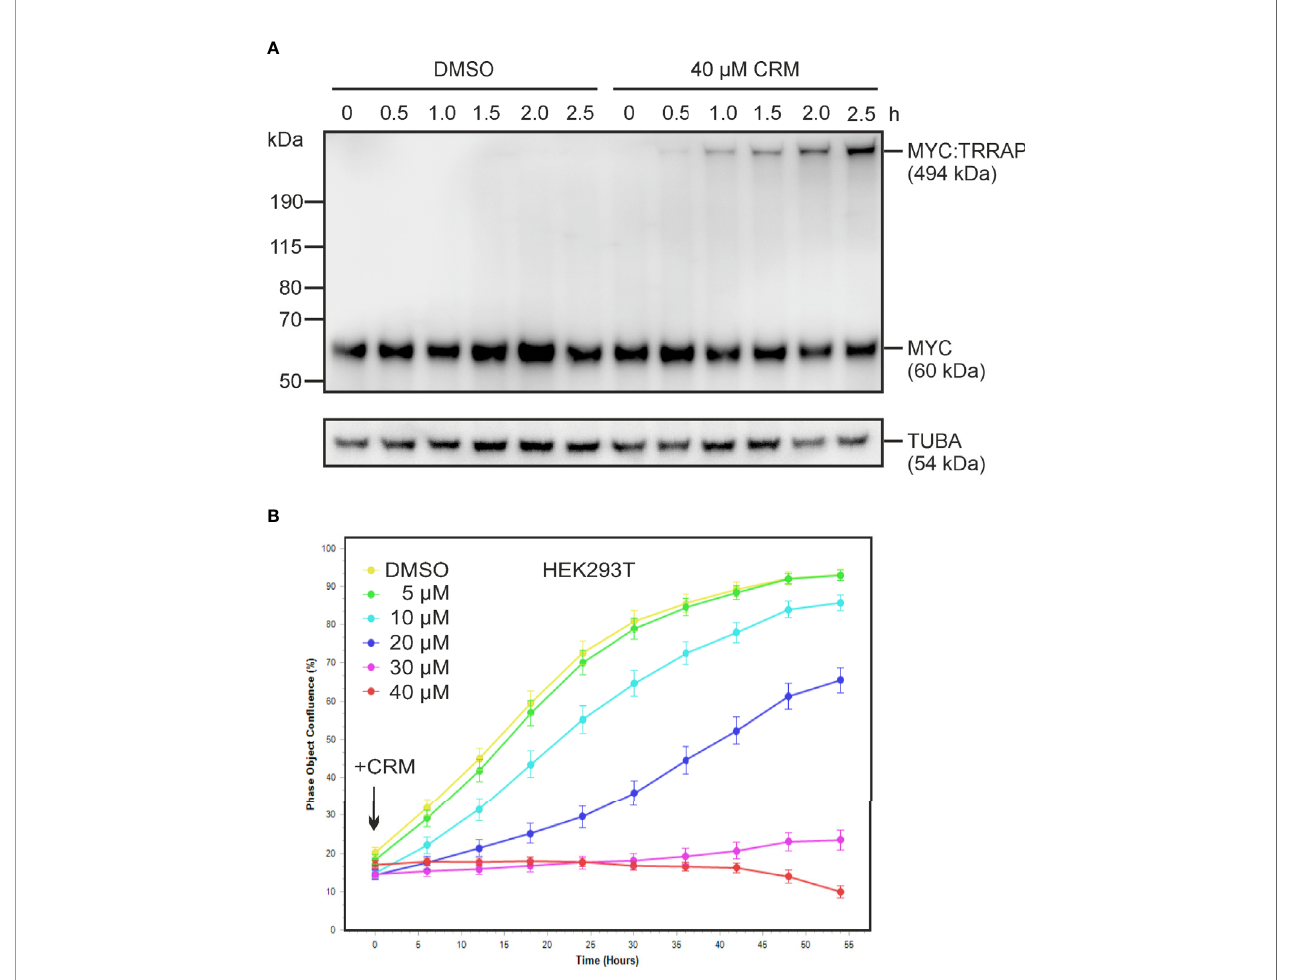
FIGURE 5 | Immediate formation of the MYC : TRRAP cross-link and inhibition of cell proliferation upon curcumin addition. (A) HEK293T cells were incubated with increasing concentrations of curcumin, or the solvent dimethyl sulfoxide (DMSO), and protein extracts prepared after the indicated time points. Proteins were analyzed by immunoblotting using a MYC- or an a -tubulin speci fi c antibody (n = 2). The position of the high-molecular weight MYC protein derivative (p494 MYC : TRRAP ) is indicated. (B) Proliferation inhibition of HEK293T cells by curcumin. Cells were seeded onto 24-well cell culture plates. The next day, curcumin was added at the indicated fi nal concentrations and cell densities measured every 6 h over a 3-day time period using an Incucyte live cell analysis system. Cells without treatment (DMSO) were used as reference. A representative experiment is shown (n =